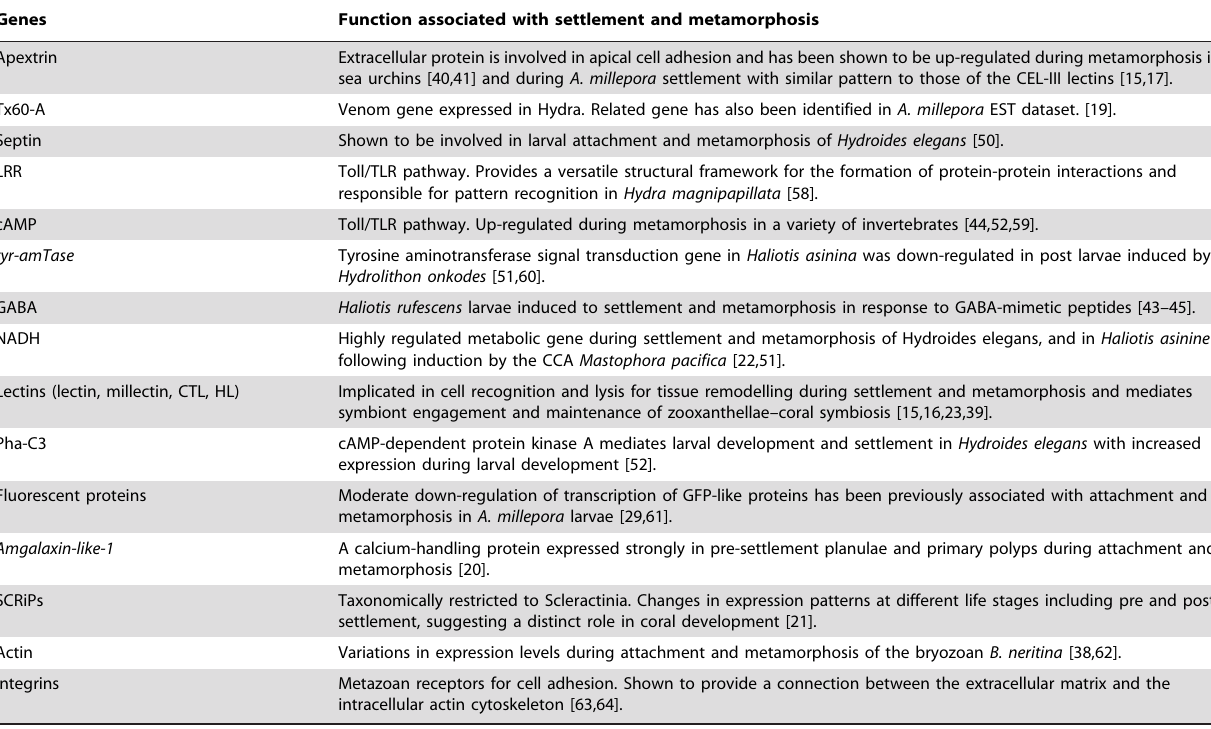
Table 1. Gene types and their functions associated with marine invertebrate larval settlement and metamorphosis.